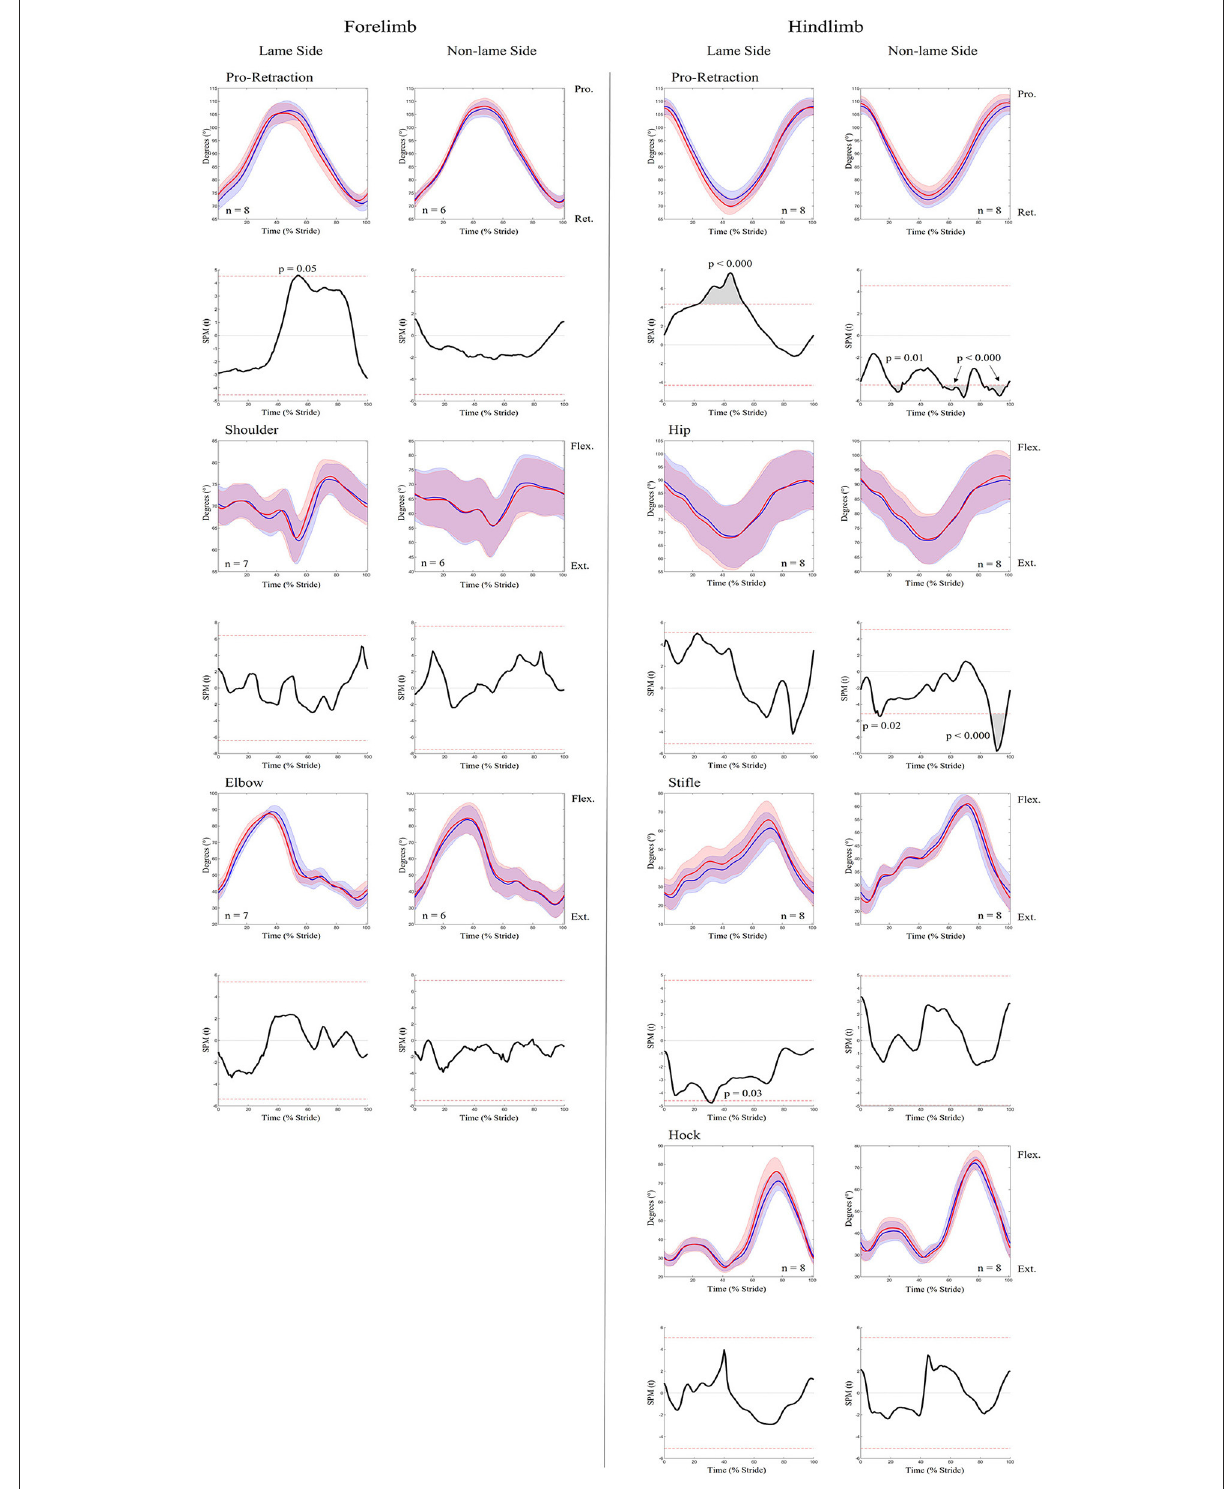
FIGURE7 SPM results for time-normalized kinematic data across the group of horses ( n = 8) for sagittal plane joint angles and pro-retraction angles of the forelimb (Left panel) and hindlimb (Right panel) during baseline 2 (blue solid lines/shaded area) and induced hindlimb lameness (red